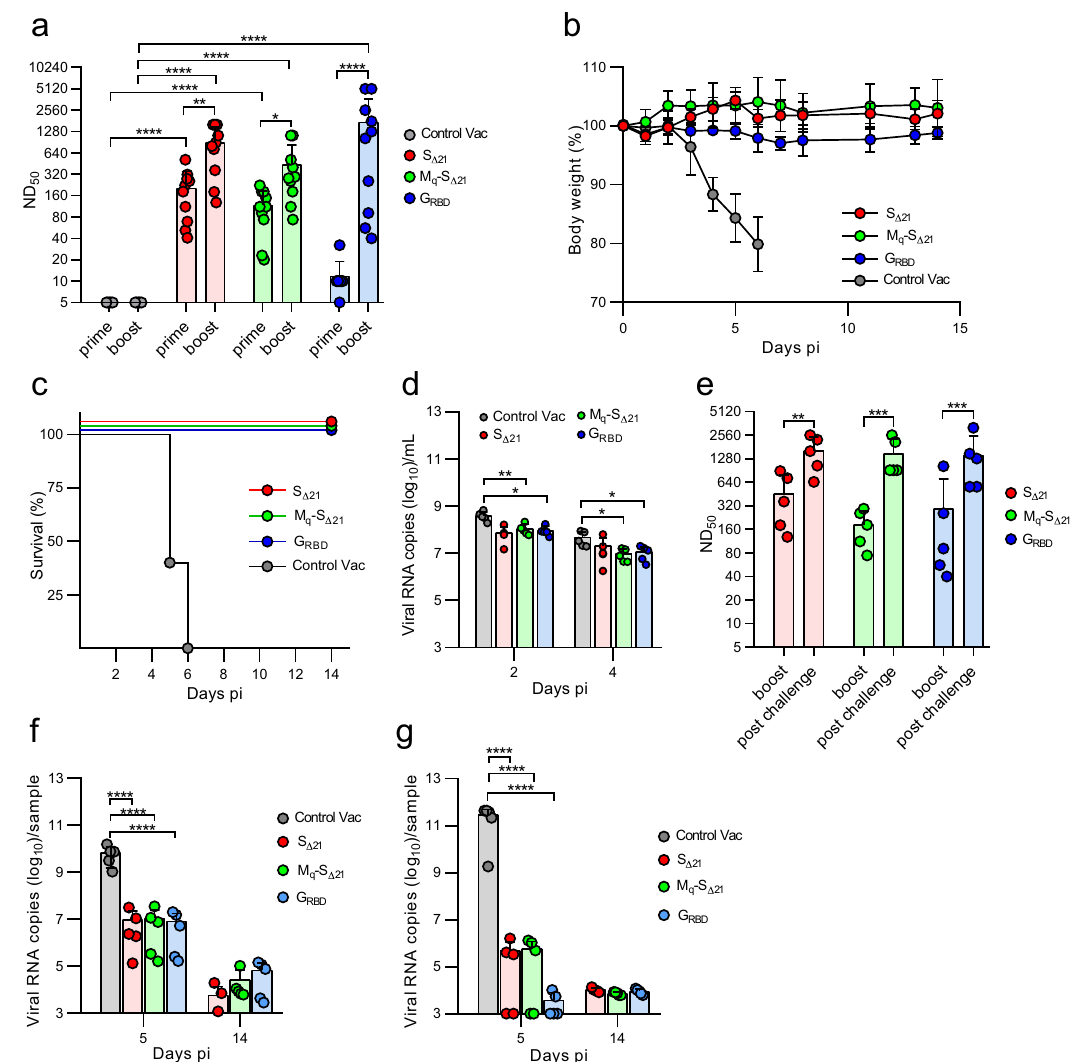
Fig. 3 Analysis of protection of immunized K18-hACE2 mice from SARS-CoV-2 challenge infection. K18-hACE2 mice were immunized twice (i.m.) with one of the following vaccines: VSV* Δ G-S Δ 21 ( n = 10), VSV*M q Δ G-S Δ 21 (n = 10), VSV* Δ G-G RBD ( n = 10), and the VSV* Δ G control vaccine ( n = 5). Five animals of each vaccine group were euthanized at day 5 pi, while the others were maintained until day 14 pi. a Determination of neutralizing serum antibody titers (ND 50 ) 21 days after the primary immunization (prime) and 18 days after the secondary immunization (boost). b , c Weight loss ( b ) and survival ( c ) of K18-hACE2 mice (d14 group) following nasal infection with 10 5 pfu of SARS-CoV- 2-S D614G . d Quanti fi cation (RT-qPCR) of SARS-CoV-2 RNA copies in oropharyngeal swab samples collected at 2 and 4 days pi. e Determination of neutralizing serum antibody titers (ND 50 ) 18 days after the boost and 14 days postchallenge infection. f , g RT-qPCR determination of viral genome copy numbers in lung ( f ) or brain ( g ) homogenates prepared from animals that were euthanized at either day 5 or day 14 pi. Mean values and standard deviations (SD) are shown. Statistically signi fi cant differences as computed by either the two-way ANOVA test ( a , d , e ) or the one-way ANOVA test ( f , g ) are indicated (* p < 0.05; ** p < 0.005; *** p < 0.0005; **** p < 14 pi (Fig. 4a, HE Lung, Day 14 pi). IHC analysis of these animals revealed solely a few infectious foci in lung sections correspond- ing to day 5 pi, which were absent from lung tissue sections corresponding to day 14 pi. Previously, SARS-CoV-2 infection of the brain has been shown to cause the death of K18-hACE2 mice 18 . Accordingly, IHC analysis of brain sections from day 5 pi revealed widespread SARS-CoV-2 nucleoprotein detection in the control vaccine group (Fig. 4a, IHC Brain) in association with very mild lesions (Fig. 4a, HE Brain), while no evidence for infection was observed in brain tissue sections from animals of either vaccine groups. Finally, semiquantitative assessment of lung pathology revealed that mice of the VSV*M q Δ G-S Δ 21 vaccine group had signi fi cantly less histopathological changes at day 5 pi compared to the control vaccine group (Fig. 4b). However, animals of the